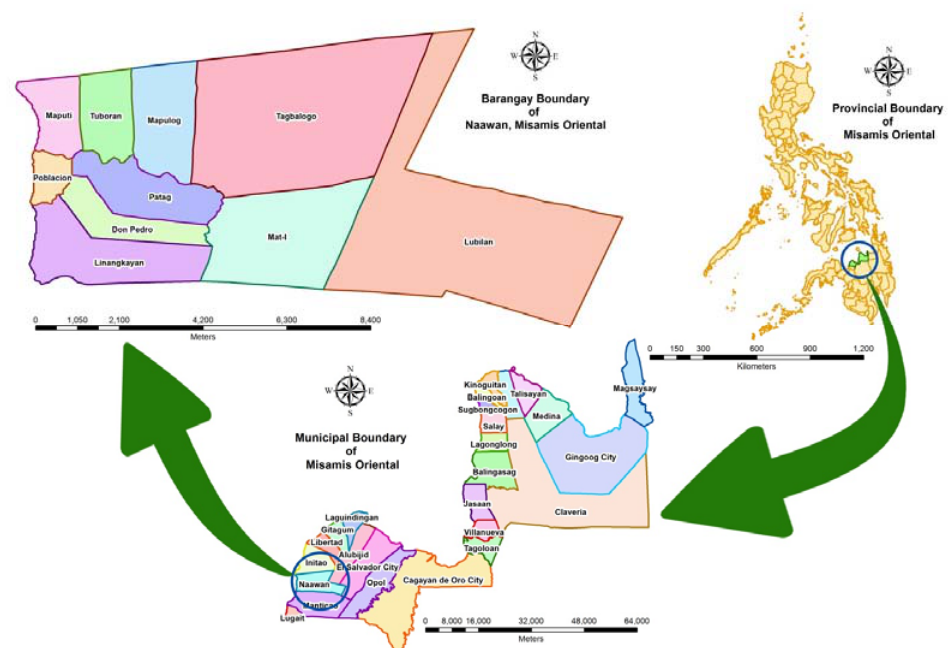
Fig. 1: Location of study area showing Bgy, Lubilan in the municipality of Naawan, Misamis Oriental